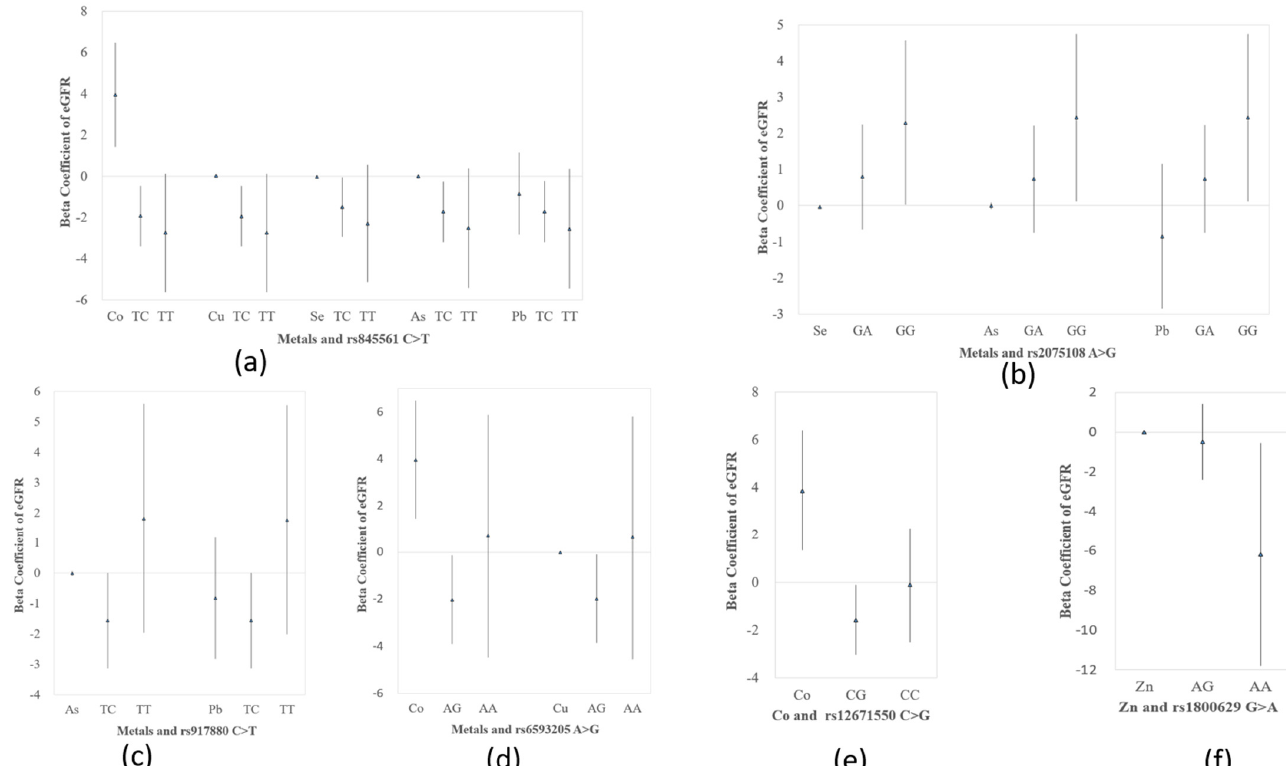
Figure 3. Beta coefficients and 95% CIs for associations between eGFR and metals and SNPs, respectively. The regression model was built as eGFR = β 0 + β M, j M j + β SNP,1 i SNP 1 i + β SNP,2 i SNP 2 i + β c Covariates + ε . Adjusted covariates included age, gender, BMI, smoking, diabetes, and hypertension. ( a ) Metals and rs845561 C > T. Regression of eGFR on metals was increased in Co ( β = 3.95, 95% CI: 1.42, 6.48) and decreased in Se ( β = − 0.03, 95% CI: − 0.04, − 0.02). Genotype TC was associated with reduced eGFR, β = − 1.93 (95% CI: − 3.4, − 0.46) adjusting for Co, β = − 1.94 ( − 3.41, − 0.47) adjusting for Cu, β = − 1.5 ( − 2.95, − 0.05) adjusting for Se, β = − 1.73 ( − 3.2, − 0.26) adjusting for As, and β = − 1.72 ( − 3.19, − 0.25) adjusting for Pb. ( b ) Metals and rs2075108 A > G. Regression of eGFR on metals was decreased in Se ( β = − 0.03, 95% CI: − 0.04, − 0.02). Genotype GG was associated with increased eGFR, β = 2.29 (0.02, 4.56) adjusting for Se, β = 2.43 (0.12, 4.74) adjusting for As, and β = 2.43 (0.12, 4.74) adjusting for Pb. ( c ) Metals and rs917880 C > T. Genotype TC was associated with decreased eGFR, β = − 1.57 ( − 3.14, − 0.002) adjusting for As, and β = − 1.57 ( − 3.14, − 0.002) adjusting for Pb. ( d ) Metals and rs6593205 G > A. Regression of eGFR on metals was elevated in Co ( β = 3.98, 95% CI: 1.45, 6.51). Genotype AG was associated with declined eGFR, β = − 2.02 ( − 3.9, − 0.14) adjusting for Co, and β = − 1.98 ( − 3.86, − 0.1) adjusting for Cu. ( e ) Metal and rs12671550 C > G. Regression of eGFR on metals was elevated in Co ( β = 3.87, 95% CI: 1.34, 6.4). Genotype CG was associated with reduced eGFR, β = − 1.57 ( − 3.04, − 0.1) adjusting for Co. ( f ) Metal and rs1800629 G > A. Genotype AA was associated with declined eGFR, β = − 6.19 ( − 11.82, − 0.56) adjusting for